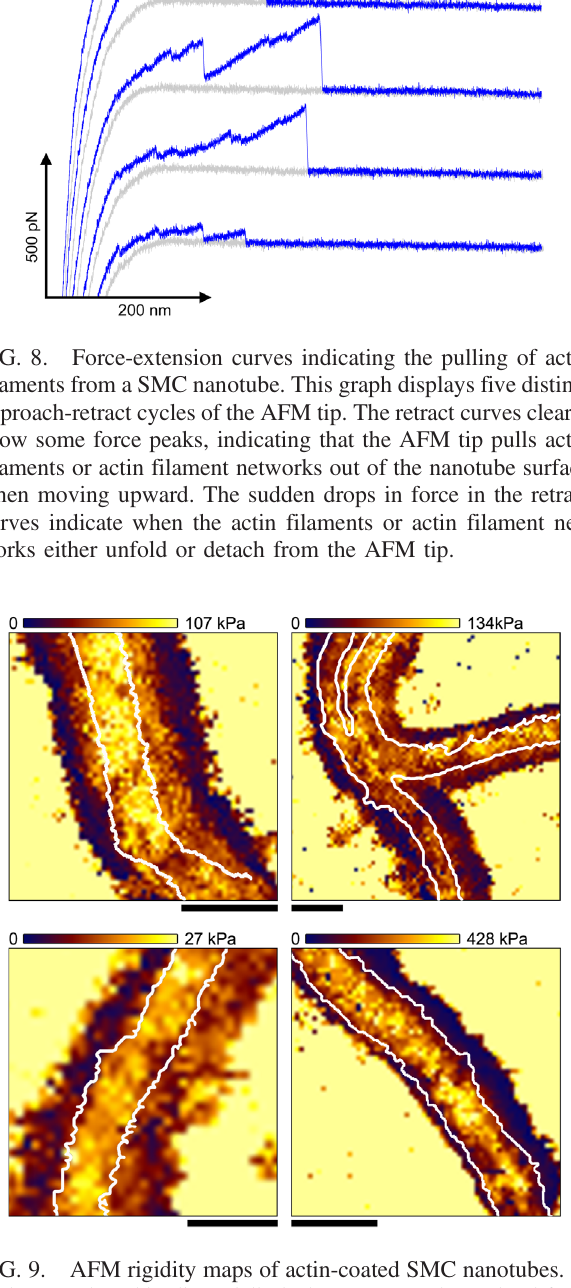
FIG. 9. AFM rigidity maps of actin-coated SMC nanotubes. In all images the white lines delimit the contours (determined from 2 pN AFM height maps; see Sec. VI) of the same nanotubes imaged prior to actin polymerization. In the four examples provided here, the actin coating clearly increases nanotube apparent width, and the actin networks siding nanotubes look softer than the nanotubes